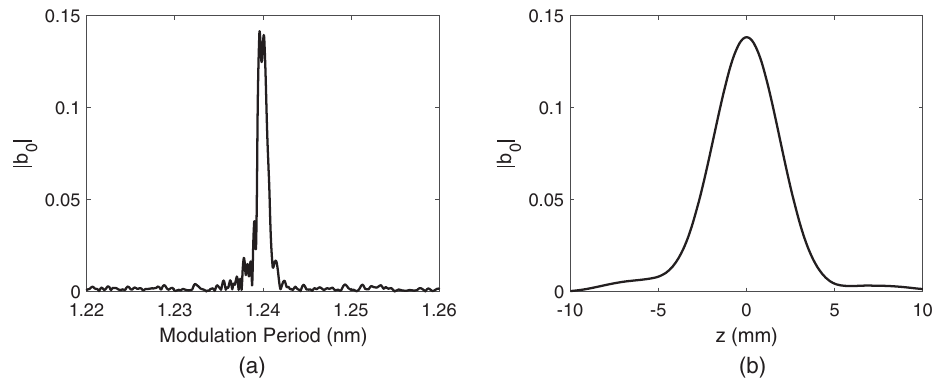
FIG. 7. (a) Individual electrons imaged after demagnification and acceleration at the entrance of the EEX line. (b) The bunching factor as a function of the transverse position in the beam.